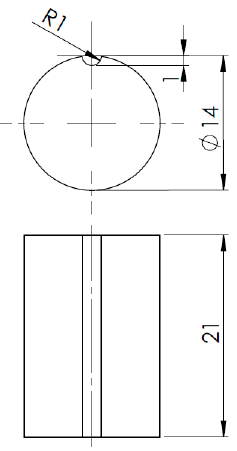
Figure 11. Drawing of unnotched ring specimen.